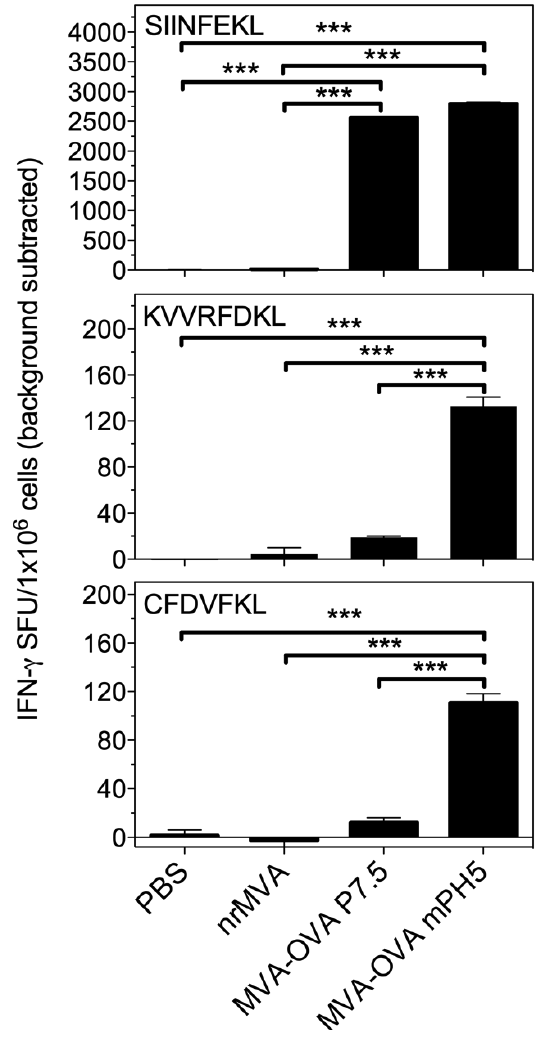
Figure 7. IFN-γ-producing cells in mice vaccinated with MVA-OVA P7.5 and MVA-OVA mPH5. Splenocytes of immunized mice were re-stimulated in vitro for 16 h with peptides encompassing the dominant (SIINFEKL) and subdominants (KVVRFDKL and CFDVFKL) MHC class I restricted epitopes of OVA to determine the number of IFN-γ secreting CD8 + T cells. Results are presented as specific spot forming units (SFU)/1 × 10 6 cells. The SEM of quadruplicate values is indicated by vertical lines. The values reported are those obtained from stimulated cells with the background from non-stimulated cells being subtracted. The results were statistically significant at p < 0.001 ( ***